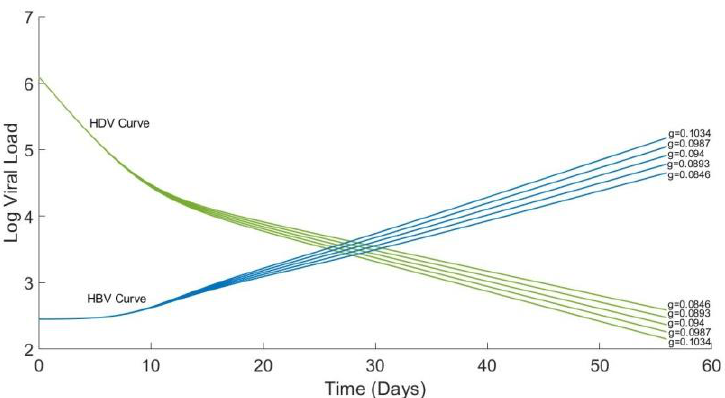
Figure A4. One-way sensitivity analysis on the impact of parameter g on predicted HBV/HDV kinetics under anti-HDV treatment. Model parameters were set to D 0 = 1,202,260, B 0 = 282, κ = 26,137, c = 0.47, n = 1.25, τ = 0.1, and ε = 0.97, with g being set at g = (0.0846, 0.0893, 0.094, 0.0987, 0.1034).